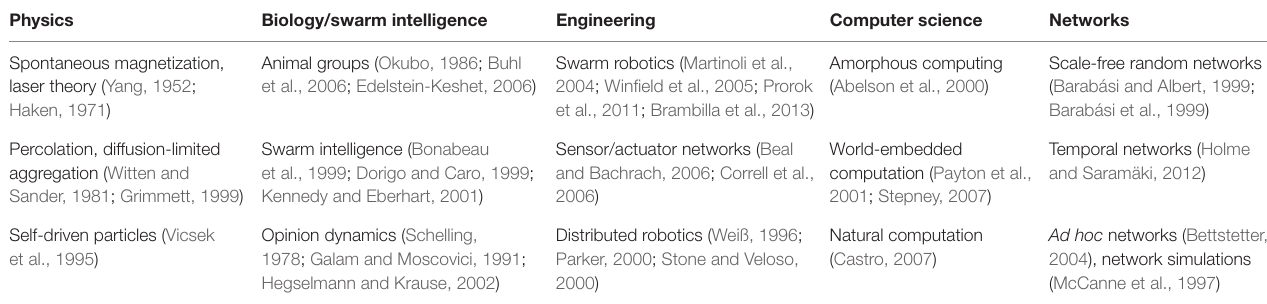
tABLe 1 | Diversity of methods for the formalization of hybrid